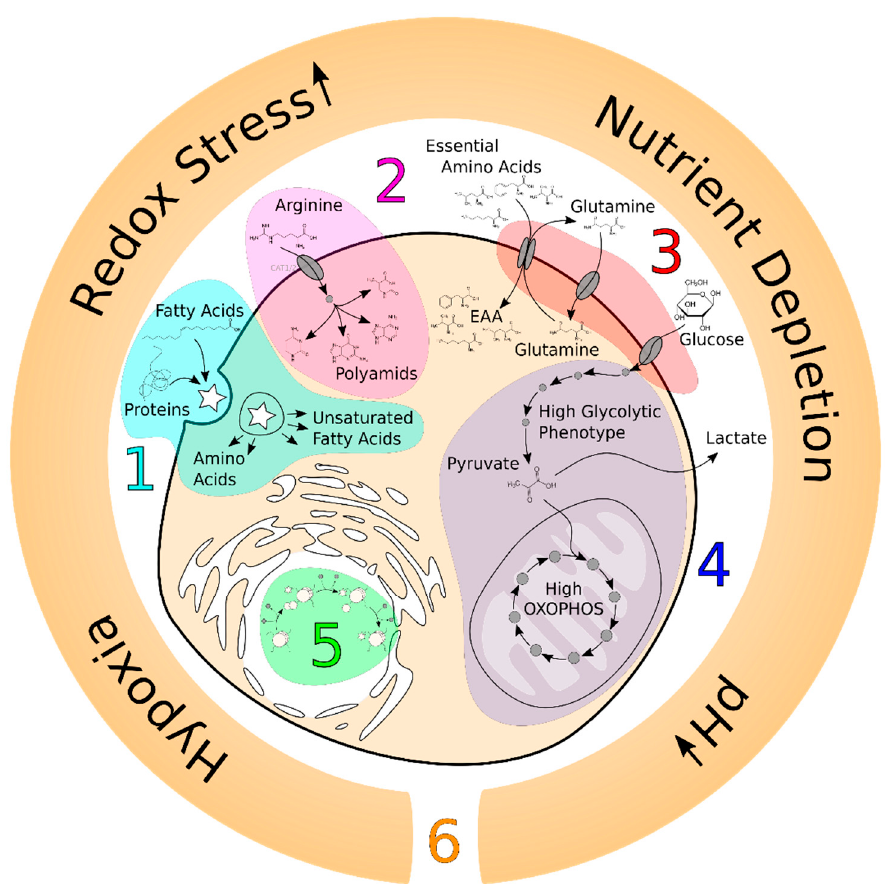
Figure 1. Metabolic hallmarks of cancer. Here, we depict six main metabolic hallmarks of cancer; (1) use of opportunistic modes of nutrient acquisition, (2) high demand for nitrogen, (3) deregulated uptake of glucose and essential amino acids, (4) use of high glycolysis/tricarboxylic acid (TCA) cycle intermediates for biosynthesis, (5) alterations in metabolite-driven gene regulation, and (6) micro- environment.